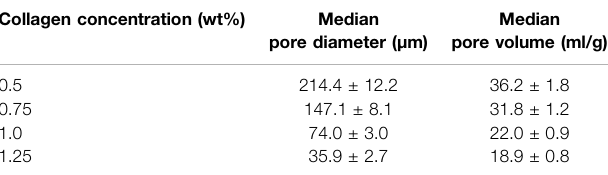
TABLE 1 | Microporosity of collagen scaffolds as quanti fi ed by Hg intrusion